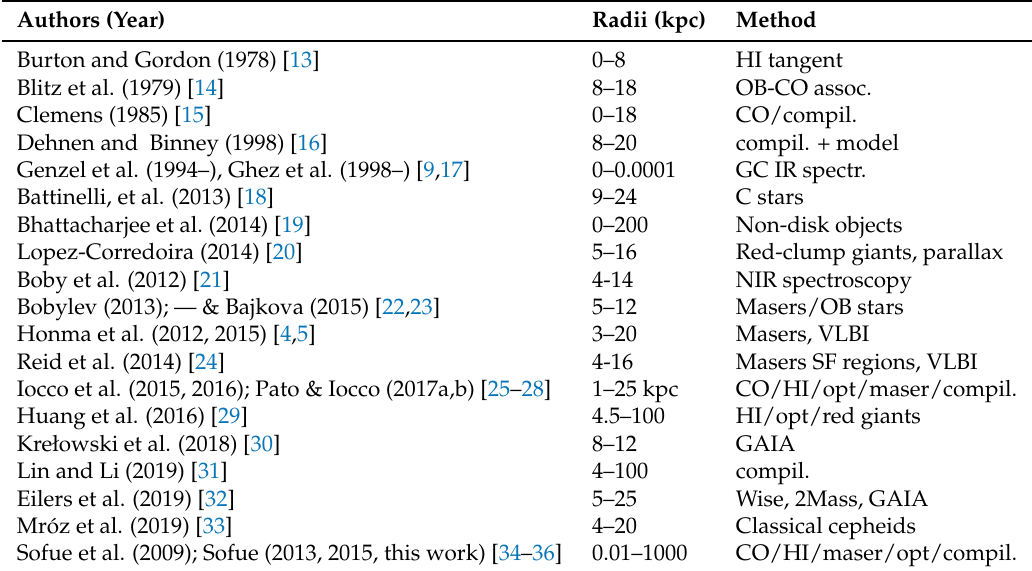
Table 2. Rotation curves (RCs) of the Milky Way